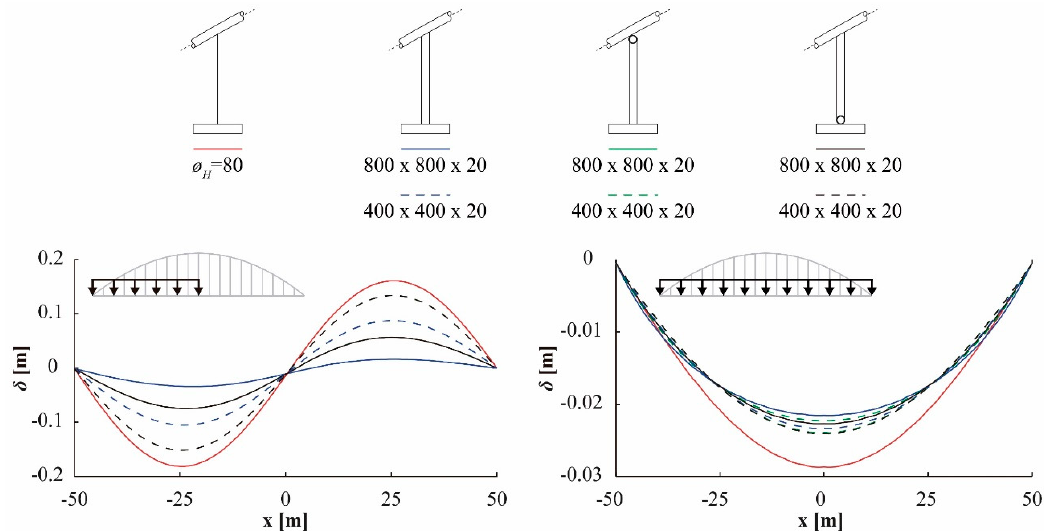
Figure 10. Deflections for stiff hangers.